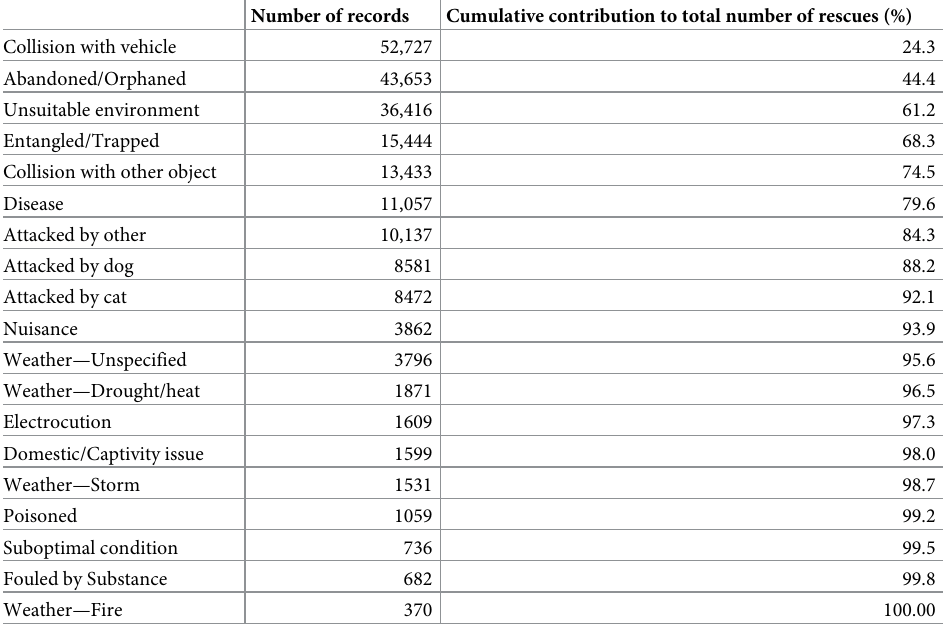
Table 6. Number of rescues and reported cause for rescue, and the contribution of each cause of admission to the total number of rescues. Values are ranked from highest contributor to lowest based on number of records. Number of